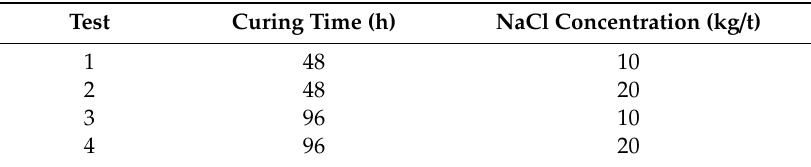
Table 3. Variables studied in the pretreatment